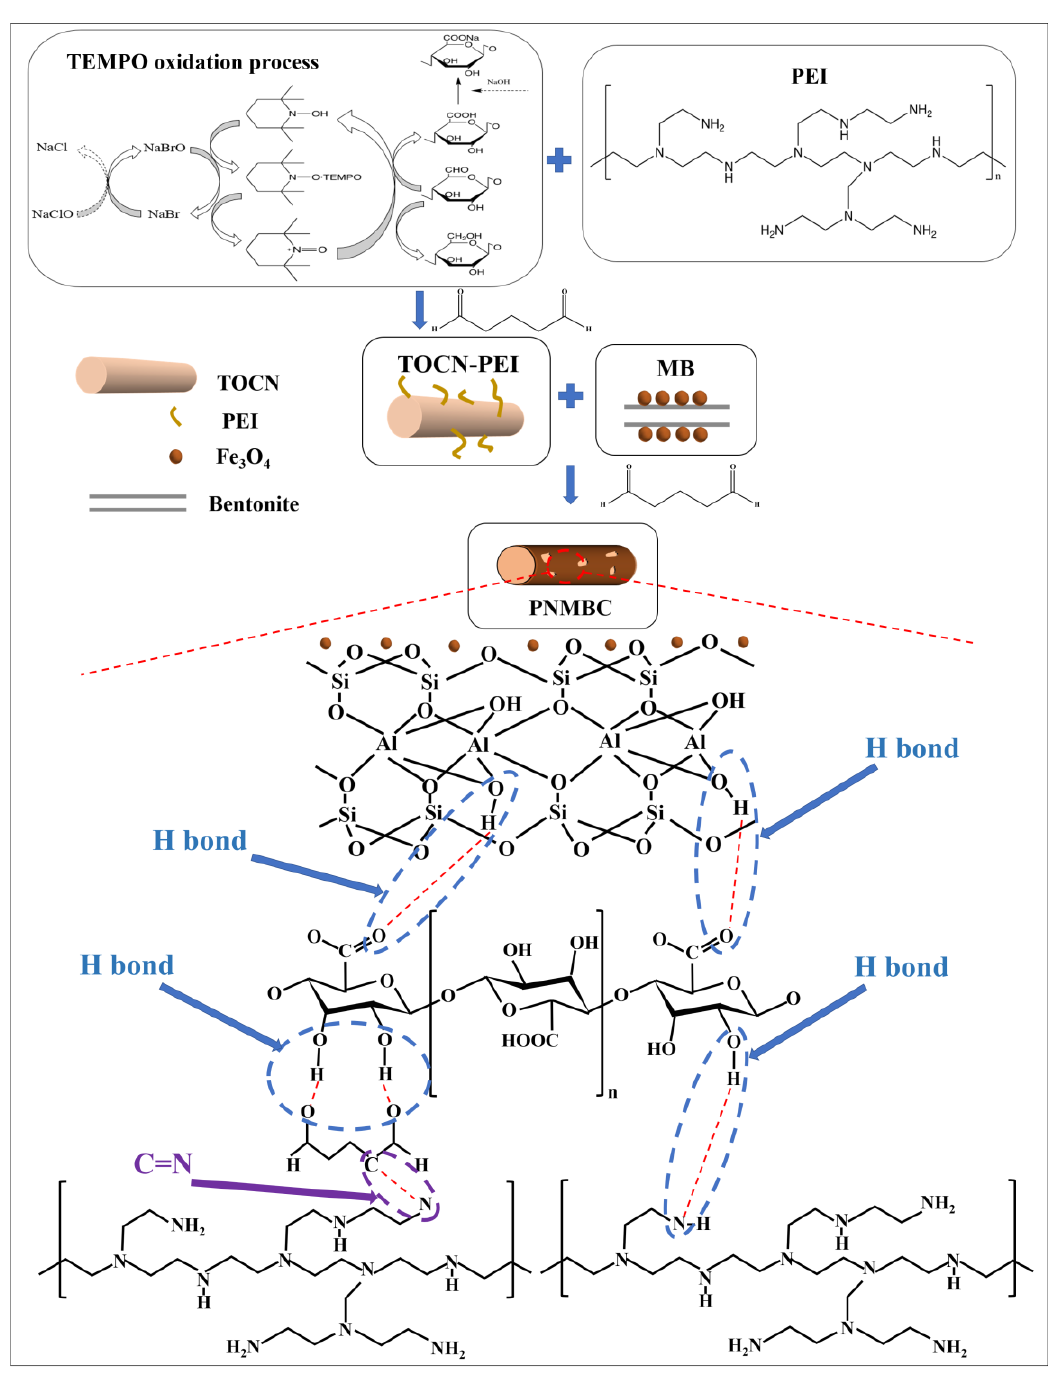
Figure 1. Schematic diagram of synthetic PNMBC biosorbent.